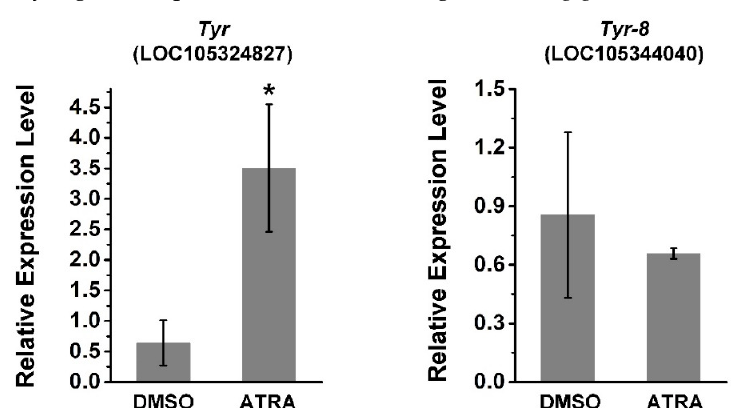
Figure 3. ATRA upregulates the expression of Tyr and Tyr - 8 . Error bars represent means of three replicates ± SD (standard deviation, n = 6, * = p < 0.05; Student’s t test).